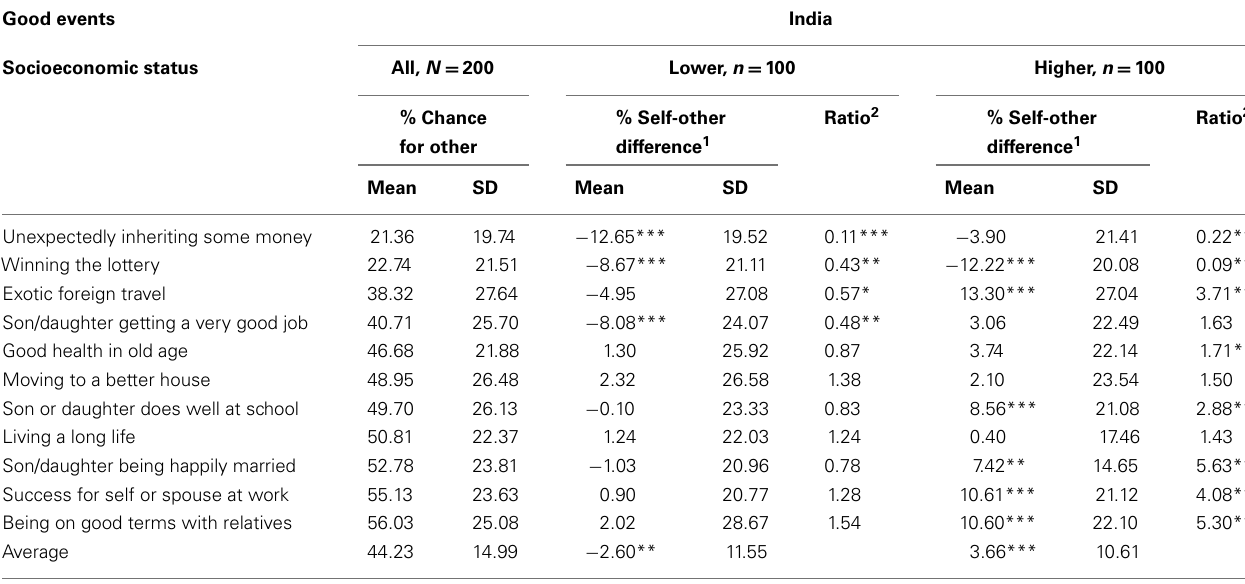
Table 4 | Good events: comparative likelihood estimates, India.